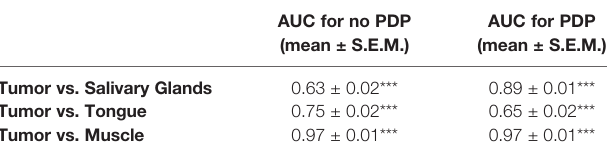
TABLE 1 | Summary of the diagnostic accuracy of Cet-IRDye800 with and without the photodynamic priming (PDP) approach.